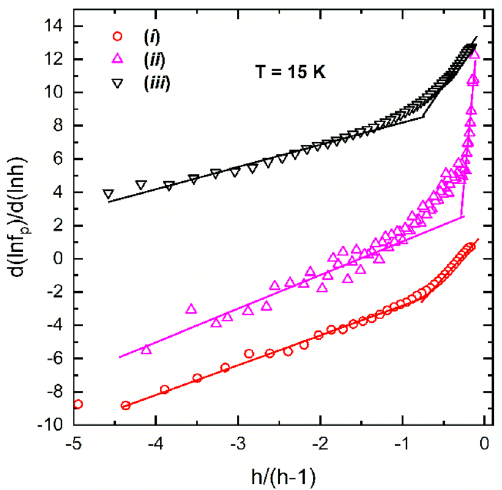
Figure 2. Dependence of the logarithmic derivative of the reduced pinning force f p on the rescaled field h /( h -1) measured at 15 K for sintered MgB 2 samples: ( i ) MgB 2 ; ( ii ) (MgB 2 ) 0.99 (Te 0.25 (HoO 1.5 ) 0.75 ) 0.01 ; ( iii ) (MgB 2 ) 0.99 (B 4 C) 0.01 . The data for samples ( ii ) and ( iii ) are shifted upwards with 6 and 12 units, respectively. Lines are guides for the